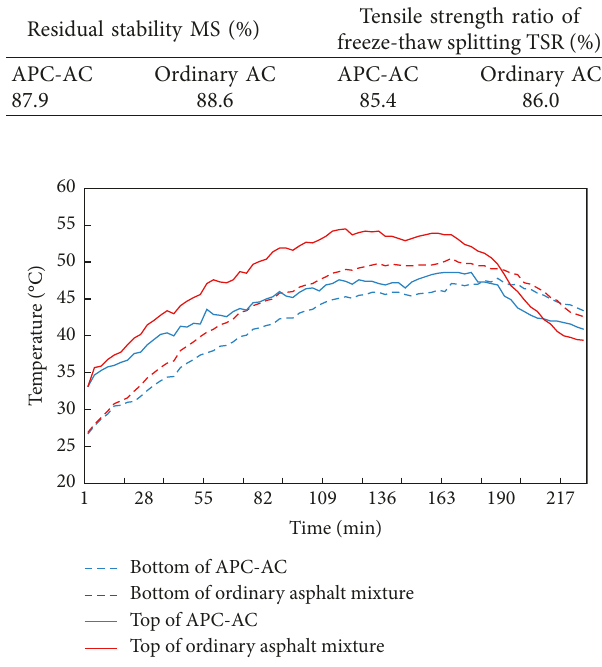
Figure 18: Temperature variation in the rutting plate samples at different positions.